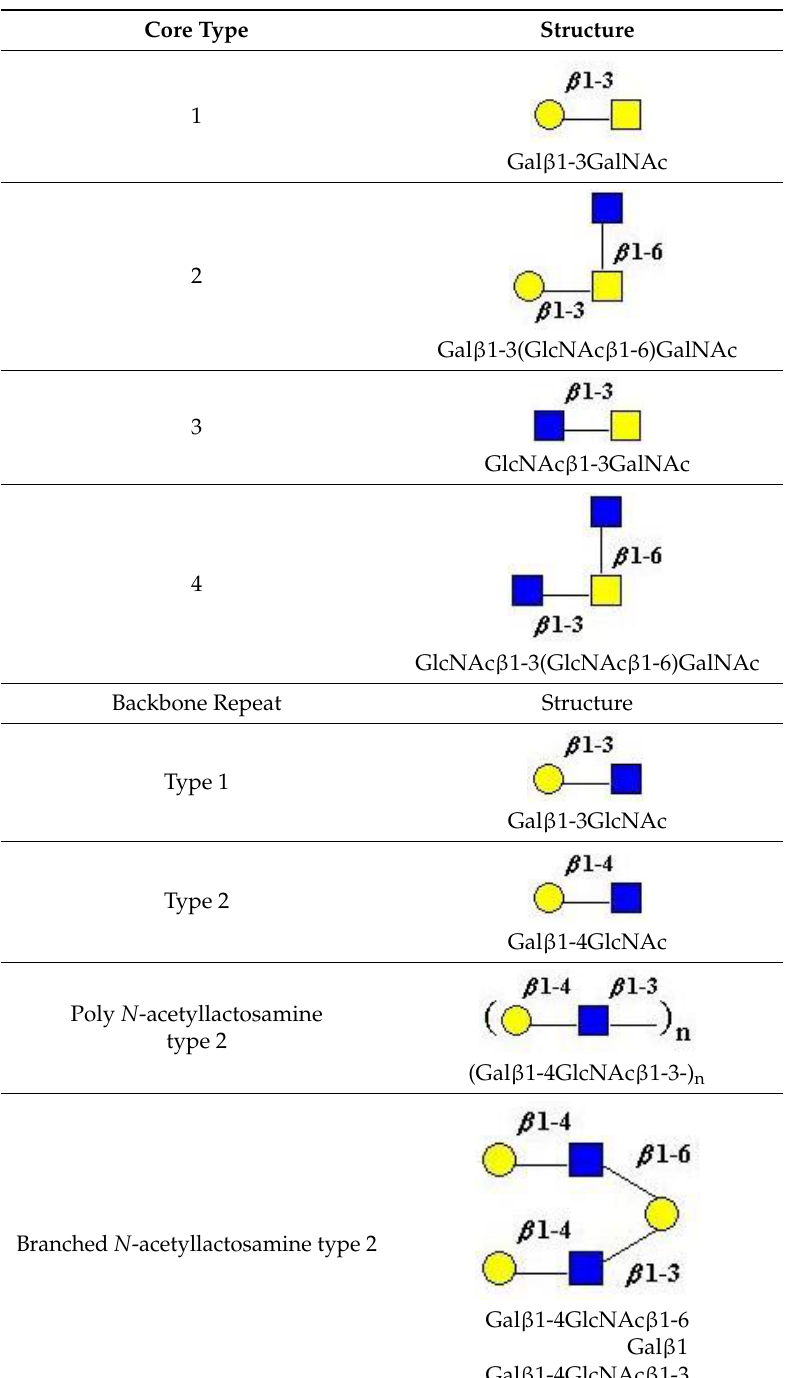
Table 3. Mucin Core and Backbone Repeat Glycan Structures.